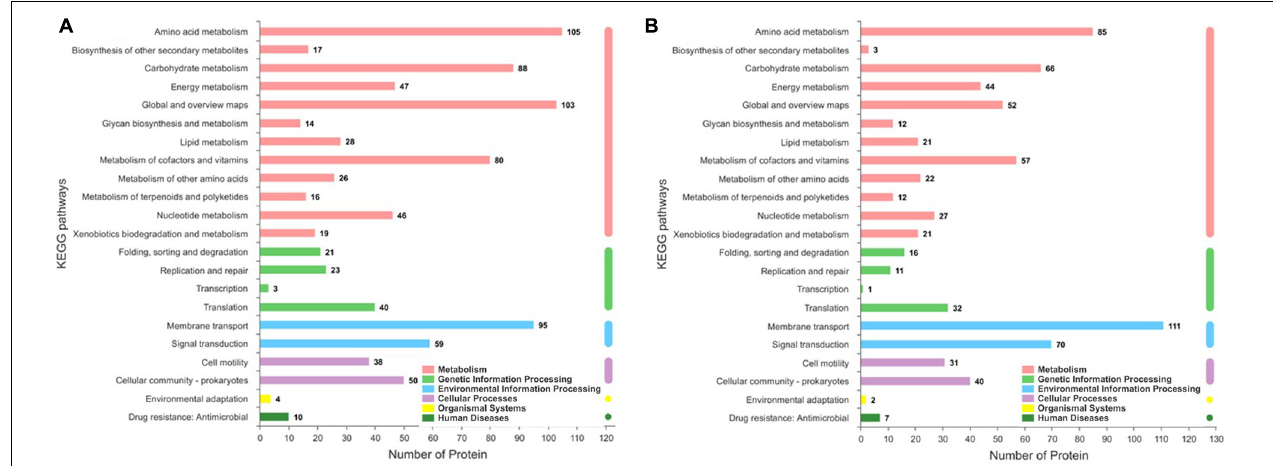
FIGURE 6 | KEGG pathways showing upregulated and downregulated protein enrichment pathways between the treatment groups and the control group. (A) Upregulated protein enrichment pathways, (B) downregulated proteins enrichment pathways. Only proteins with a fold change greater than 2.0 or less than 0.5 ( p < 0.05) were